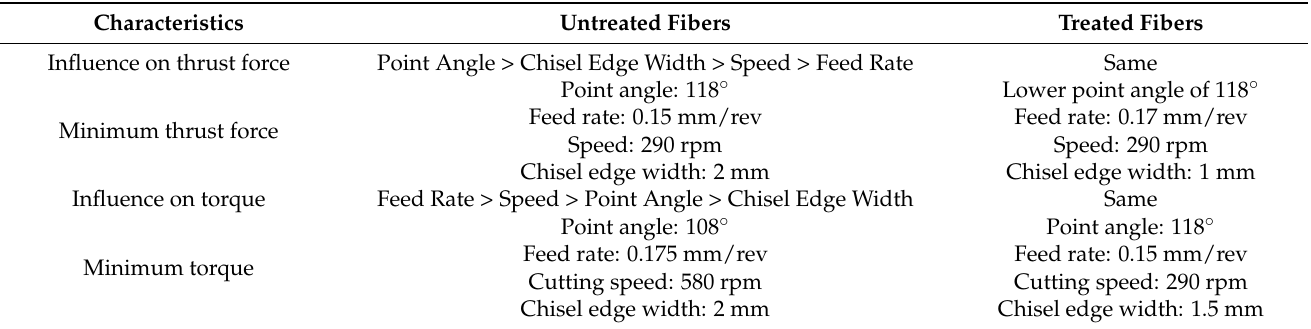
Table 2. Optimal characteristics for thrust force and torque in kenaf fiber/PVA composite (elaborated from